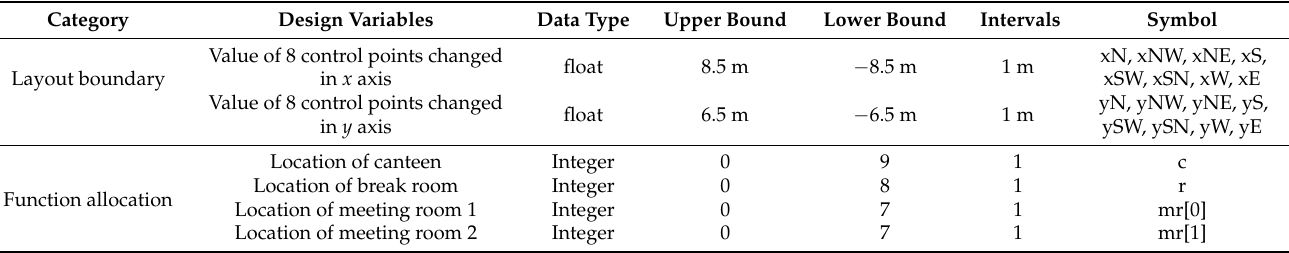
Table 2. Design variables and their domains.